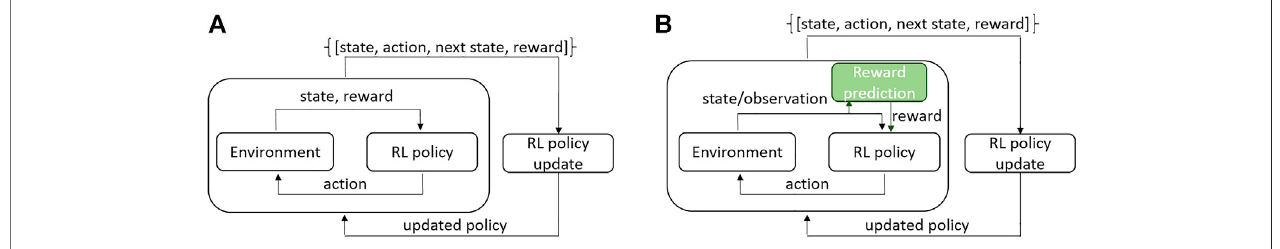
FIGURE 1 | RL architecture: (A) classical online RL where state and reward are returned by the environment; (B) a real-world scenario where instead of full state only its observation is obtained and reward is predicted from the observation. Our contribution lies in the reward prediction block marked in